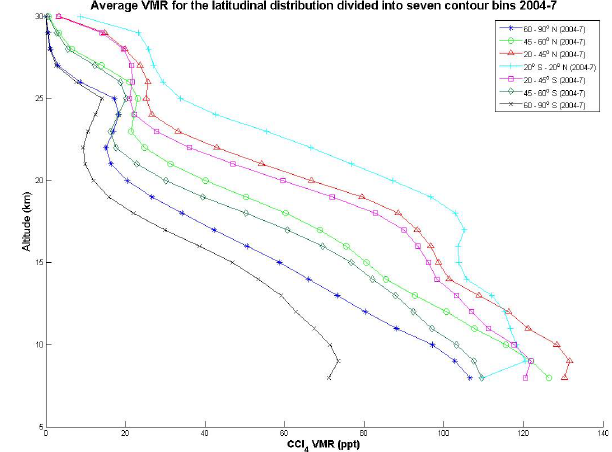
Fig. 3. A near global distribution of the average volume mixing ra- tio of carbon tetrachloride (inppt) as a function of latitude between 8 and 30km altitude obtained from ACE-FTS profiles from Febru- ary 2004 and August 2007 is depicted. The average tropopause height is marked with a dashed black line. The data is taken from the DMPs for each occultation and then averaged for each latitude bin, as with the carbon tetrachloride measurements.